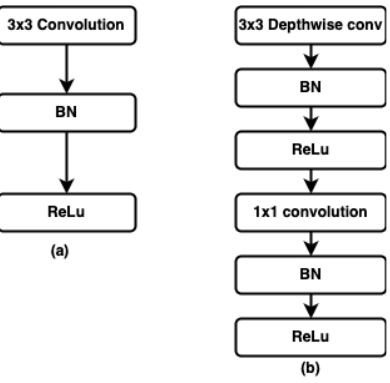
Figure 2. Difference between standard and depth-wise separable convolutions ( a ) and standard ( b ) depth-wise separable convolutions with depth-wise and pointwise layers [36].